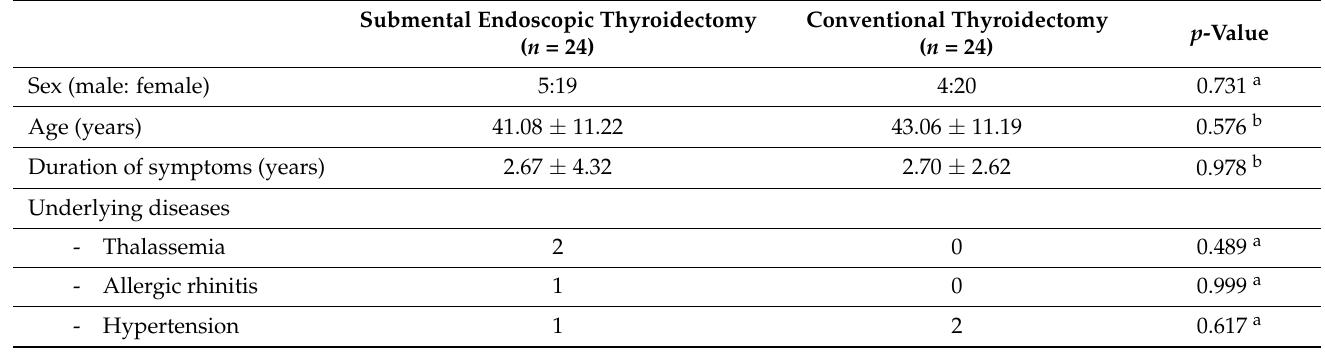
Table 1. Demographic data.